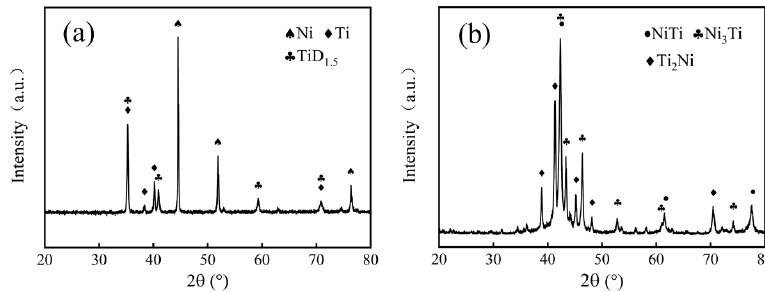
Figure 10. XRD patterns of ( a ) Ni-Ti blended powders and ( b ) NiTi alloy.